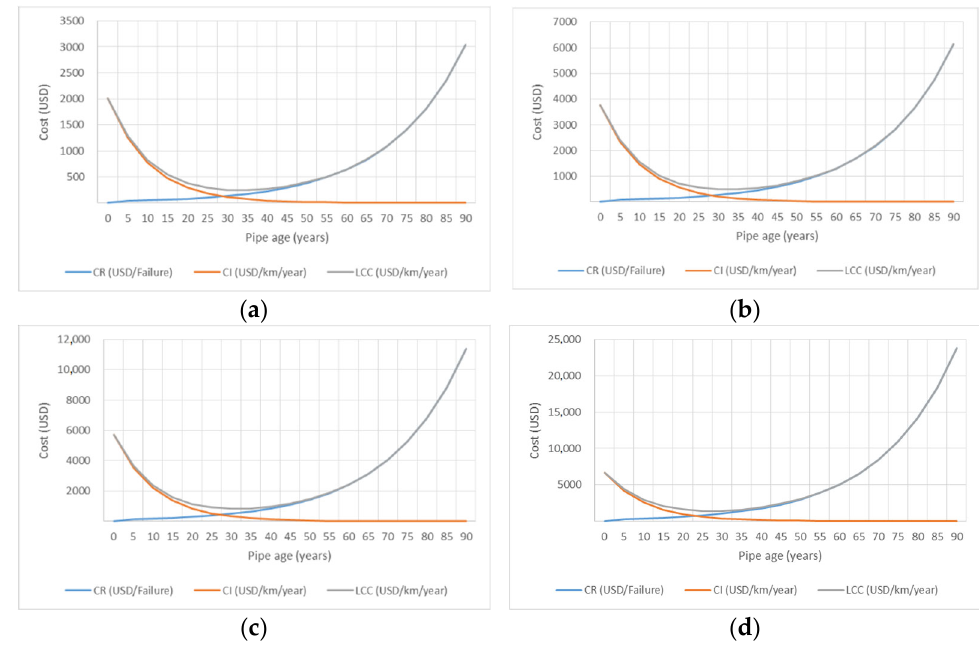
Figure 11. LCC curves of ML estimation. ( a ) PVC 63 mm; ( b ) PVC 90 mm; ( c ) PVC 110 mm; ( d ) PVC 150 mm. ( d ) PVC 150